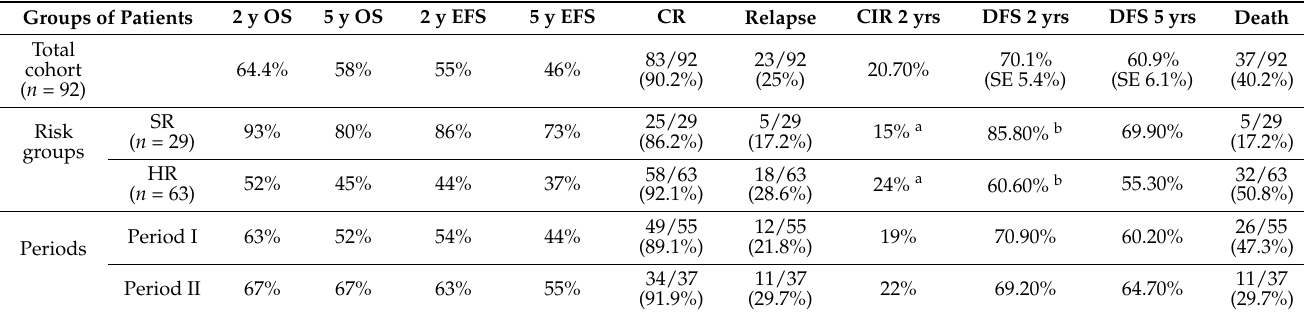
Table 2. Summary of outcome